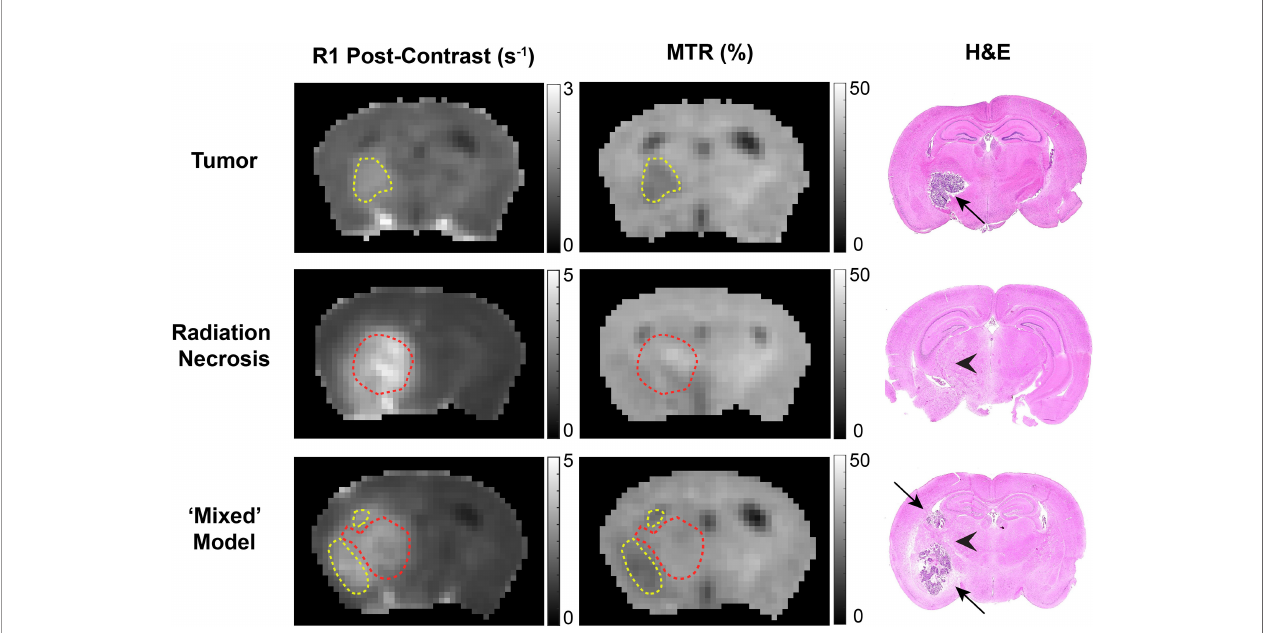
FIGURE 5 | Contrast-enhanced (left) T1-weighted images, (middle) magnetization transfer ratio (MTR) parametric maps, and (right) H&E staining of: (top) pure tumor; (middle) pure radiation necrosis; (bottom) mixed model, with tumor growing within a region of radiation necrosis. Red contours outline regions-of-interest of radiation necrosis; yellow contours outline regions-of-interest of tumor. In the H&E, black arrows identify tumor and black arrow heads identify